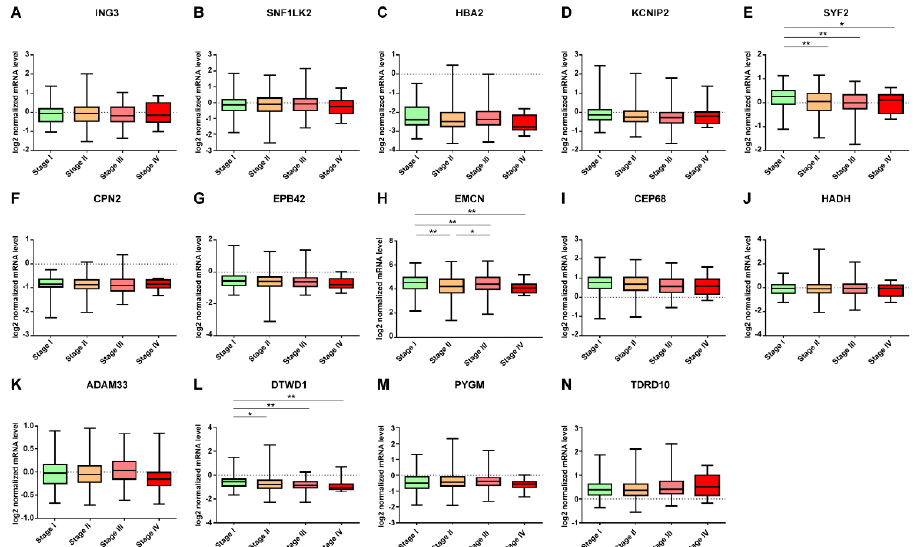
Figure 5. Expression patterns of DE mRNAs downregulated in breast cancer tissue according to tumor stages. ( A ) ING3, ( B ) SNF1LK2, ( C ) HBA2, ( D ) KCNIP2, ( E ) SYF2, ( F ) CPN2, ( G ) EPB42, ( H ) EMCN, ( I ) CEP68, ( J ) HADH, ( K ) ADAM33, ( L ) DTWD1, ( M ) PYGM, and ( N ) TDRD10. Data are reported as mean ± SD. * p < 0.05, ** p < 0.01.